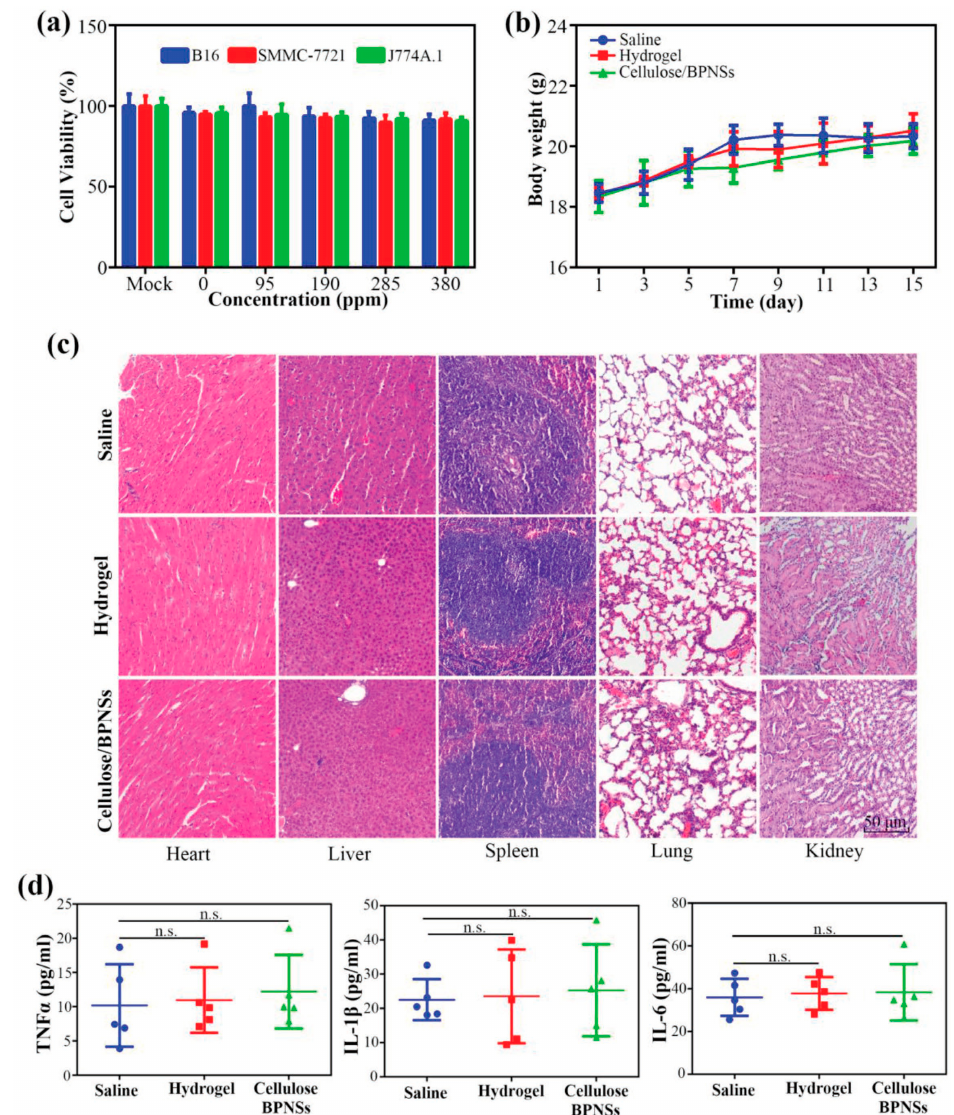
Figure 14. Toxicity assays: ( a ) In vitro toxicity assays. Relative cell viability of B16, SMMC-7721, and J774A.1 cells after incubation with Mock (no treatment) and hydrogels without black phosphorus nanosheets (BPNSs) or with BPNS concentrations of 95, 190, 285, and 380 ppm for 24 h; ( b , c ) in vivo toxicity assays after subcutaneous injection of 100 μ L of saline, hydrogel, or cellulose/BPNSs; ( b ) body weight was monitored on days 1, 3, 5, 7, 9, 11, 13, and 15; ( c ) hematoxylin and eosin (H&E) staining of the heart, liver, spleen, lung, and kidney on day 15; ( d ) Immunotoxicity assays in vivo for protein levels of TNF α , IL-1 β , and IL-6 in the serum of C57BL/6 mice after indicated treatments. [138].